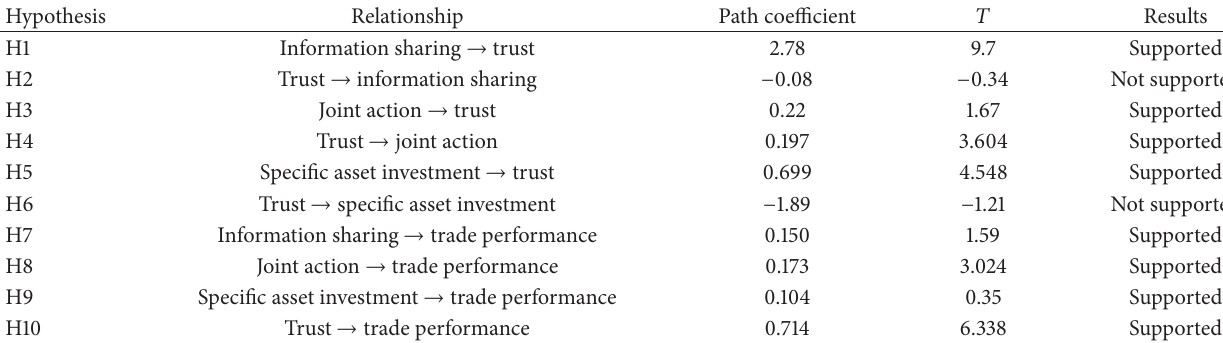
Table 16: Results of hypothesis